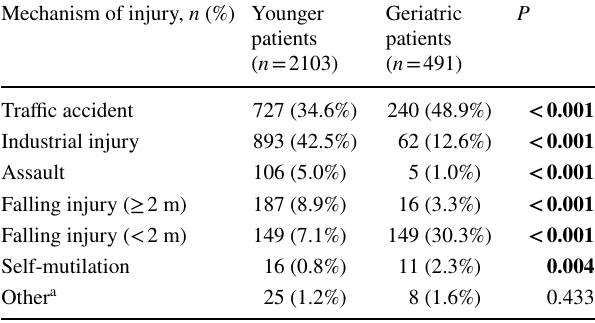
Table 3 Comparison of mechanism of injury by patient population